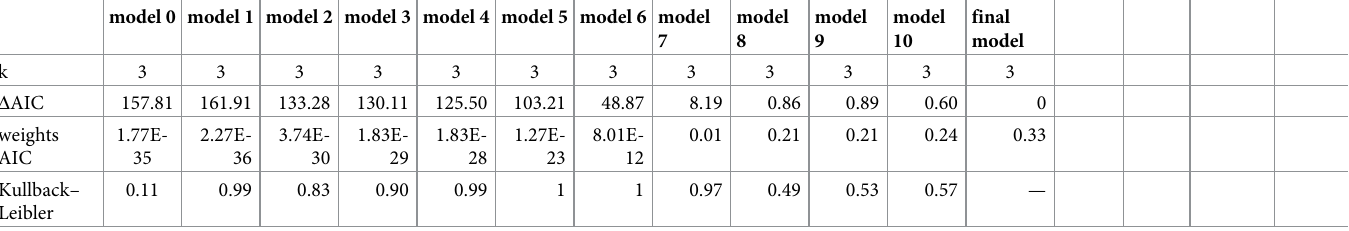
those mothers bearing a female. Mothers weight increased with mother age (p = 0.023) at a lower rate when the mother was bearing a male than a female, with this only corroborated by AIC model selection basis (Fig 5). The model indicated that mother weight responded to phys- ical environment variables in a more complex fashion than the response of calf growth to the same set of physical variables. Mother weight responded in a quadratic fashion to air tempera- ture (p = 0.002), while the response to humidity and wind speed was positive and almost linear (p < 0.001, Figs 6 and 7). Mother weight response to solar radiation followed a similar